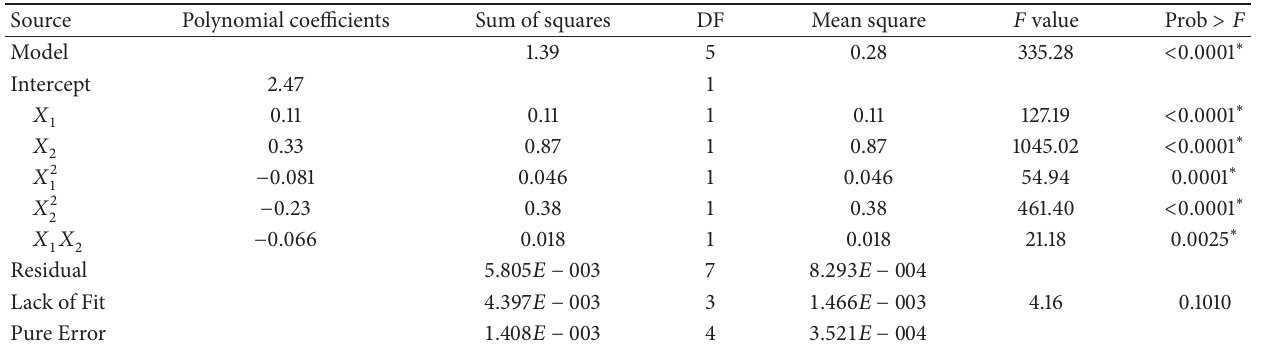
Table 4: Analysis of variance for the quadratic polynomial model of biomass production by Cunninghamella bainieri 2A1. Source Polynomial